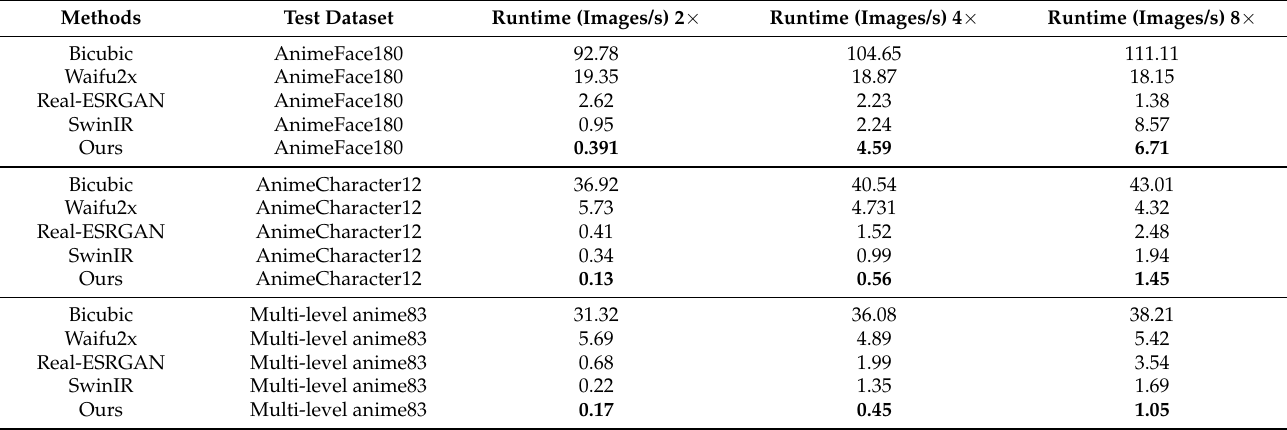
Table 6. The runtime comparison of our proposed method against the state-of-the-art methods. The best results are indicated with